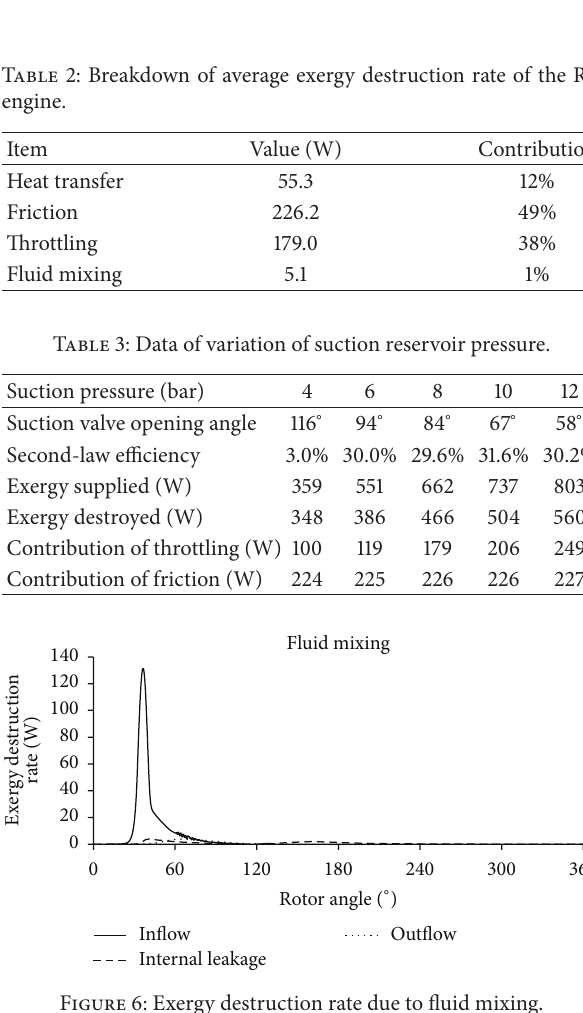
Figure 5: (a) Exergy destruction rate due to throttling and (b) pressure variations of the fluid.